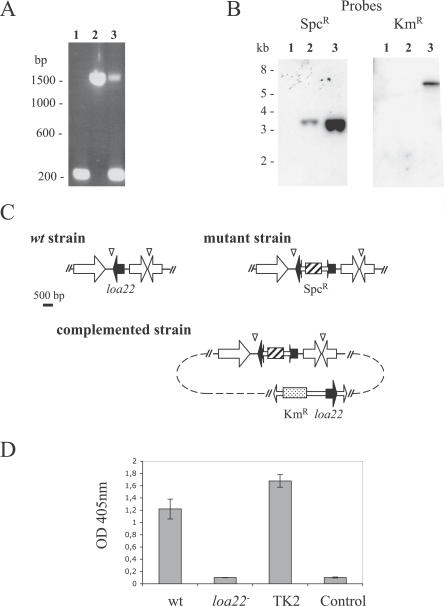
Disruption and Complementation of loa22 in L. interrogans
(A and B) Analysis of chromosomal DNA from the parental (lane 1), mutant loa22− (lane 2), and complemented TK2 strains (lane 3) by PCR with primers S1a and S1b (A) and Southern blot of EcoRI-digested DNA probed for hybridization with the spectinomycin (SpcR)- and kanamycin (KmR)-resistant cassettes (B). Primers S1a and S1b are located in the flanking sequences of the insertion site of the spectinomycin-resistant transposon into loa22. This analysis revealed that there was an insertion of 1.3 kb in the mutant loa22− strain and that an additional copy of loa22 was present in the complemented strain.(C) Schematic representation of the genotype of the parental (wt), mutant, and complemented strains. Arrowheads in white indicate the position of EcoRI sites.(D) ELISA of plates with total bacterial antigens and Loa22 antiserum (serum dilution 1:800).